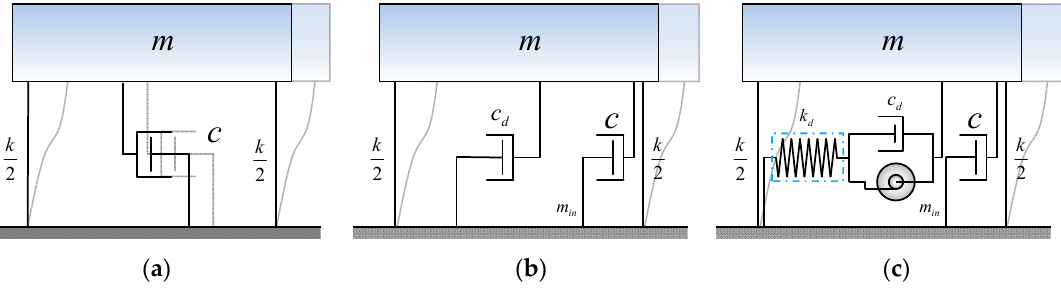
Figure 4. Mechanical models of the analyzed structures: ( a ) original single-degree-of-freedom (SDOF) element; ( b ) SDOF element connected to a single dashpot; ( c ) SDOF element connected to the tuned viscous mass damper (TVMD).